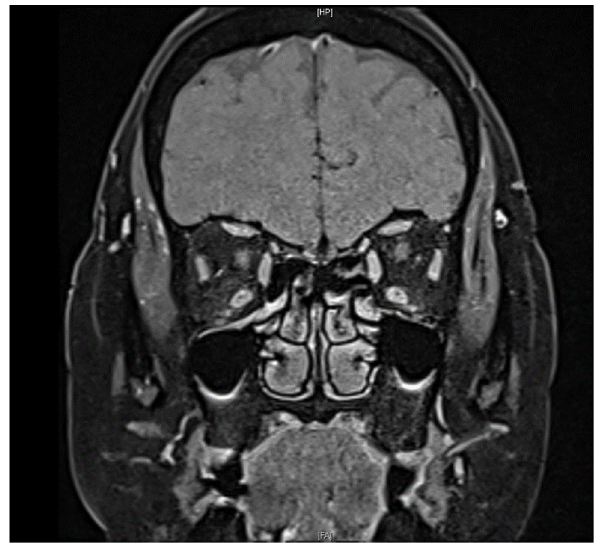
Figure 2. ( a ) Optical coherence tomography (OCT) showed peripapillary retinal nerve fiber layer (pRNFL) edema and thinning of the macular ganglion cell layer (GCL) in the superior hemisphere in the patient’s left eye, ( b ) corresponding to an inferior altitudinal visual defect.